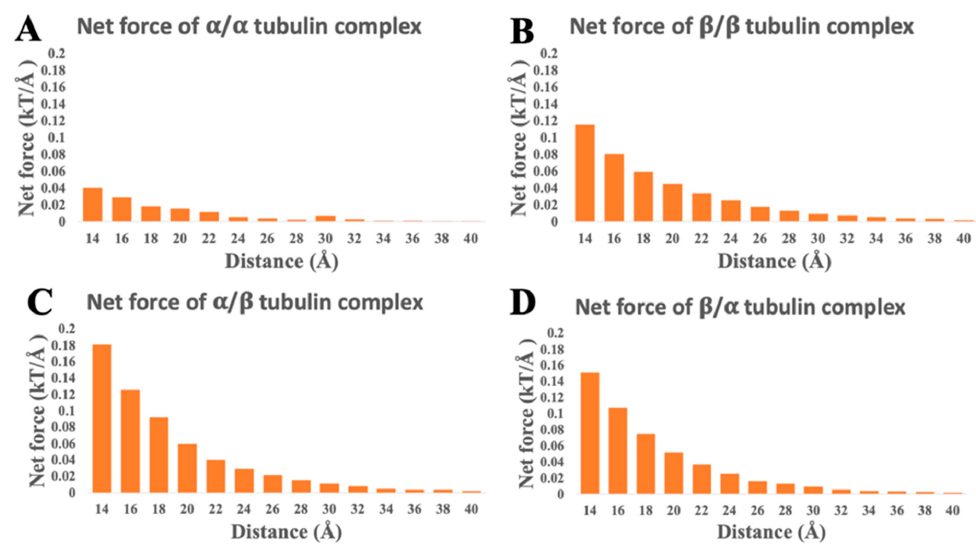
Figure 5. The magnitudes of electrostatic forces for tubulin complexes ( α / α , β / β , α / β , β / α ) at distances from 14 Å to 40 Å with a step size of 2 Å. ( A ) α / α tubulin complex. ( B ) β / β tubulin complex. ( C ) α / β tubulin complex. ( D ) β / α tubulin